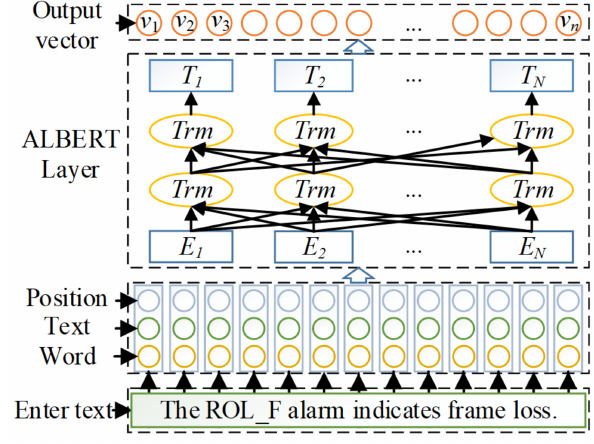
Figure 3. Faulty text pre-training structure diagram.